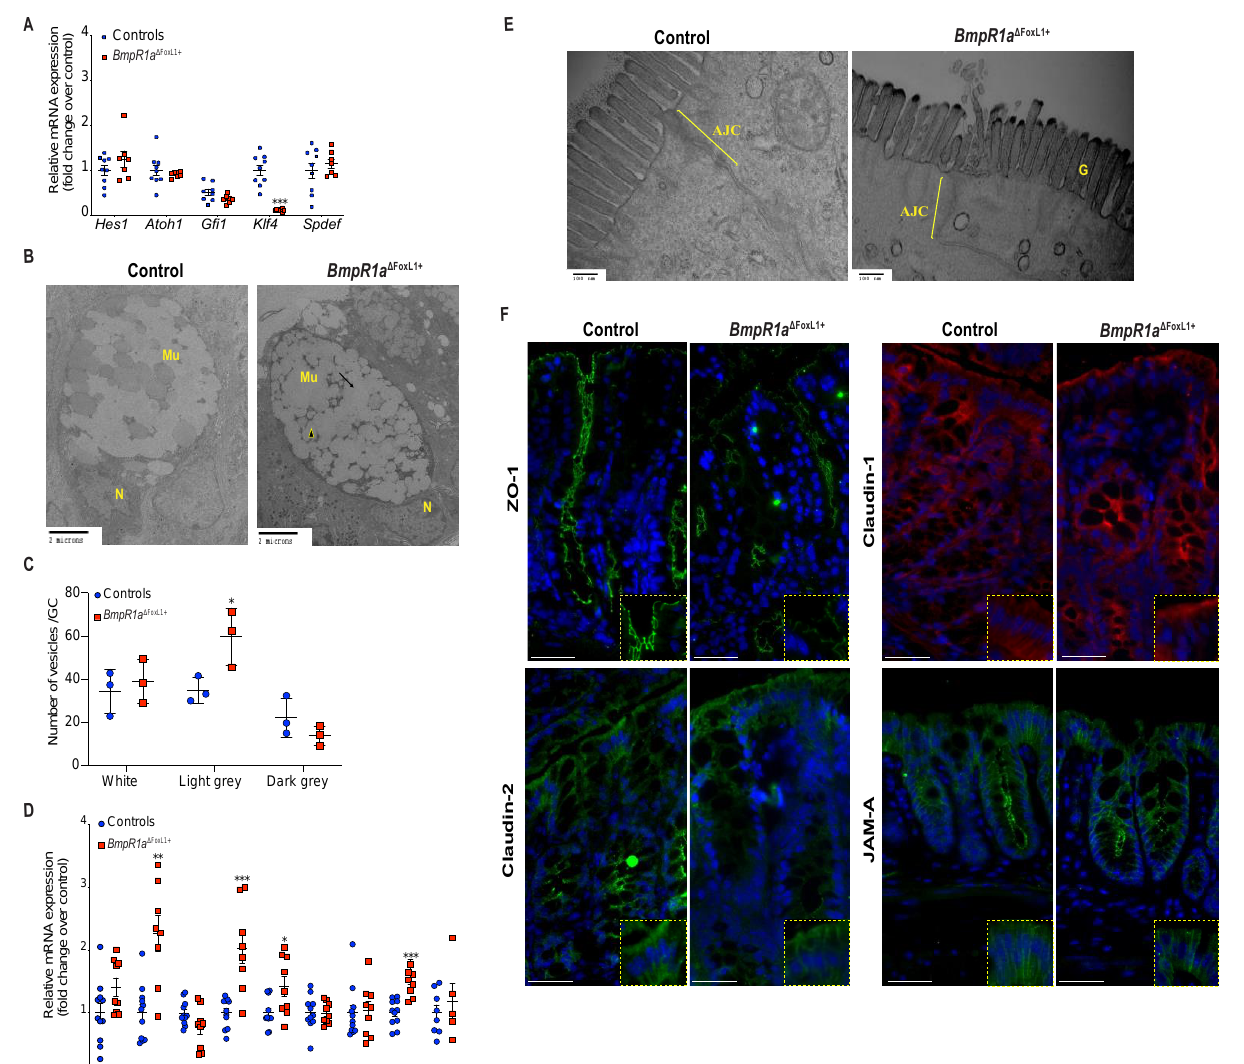
Figure 3. BmpR1a Δ FoxL1+ mice displayed abnormalities in goblet cell vesicles and presented dysregulated mucus maturation and structural gene expression. ( A ) Relative mRNA levels of the colonocyte/secretory lineage specification Hes1 and Atoh1 , along with committed-secretory cell toward the goblet fate or maturation Gfi1 , Spdef and Klf4 . A significant decrease was observed for Klf4 mRNA levels in mutant mice while other mRNAs were not modulated between mutant and control mice ( N = 7 – 9). ( B ) Ultrastructural analysis of the goblet cells revealed vesicles without mucin diversity, disturbed morphology in BmpR1a Δ FoxL1+ mice ( N = 4). ( C ) Vesicles pattern quantification revealed a significant increase in light grey vesicles in mutant goblet cells when compared to controls ( N = 3). ( D ) BmpR1a Δ FoxL1+ mice showed a significant increase in Fut2 , Muc2 , Muc4 and Agr2 mRNA levels in mutant mice. ( E ) Ultrastructural analysis of the glycocalyx and the apical junctional complex (yellow bracket) revealed that the latter was not modified between both groups and showed loss of glycocalyx in BmpR1a Δ FoxL1+ mice ( N = 4). ( F ) Immunofluorescence against ZO-1, claudin-1 and 2 as well as JAM-A revealed no modulation in the tight junction complex proteins between both groups ( N = 3). ( C ) 2-way ANOVA test. Data are presented as the mean ± SD. ( D ) Mann – Whitney test. N: Nucleus; Mu: Mucin vesicles; G: Glycocalyx; AJC: Apical junctional complex. Fold-change was normalised to that of TATA box protein ( TBP ) used as housekeeping gene ( N = 10). * p < 0.05; ** p < 0.01; *** p < 0.001 analysed by Mann – Whitney test.